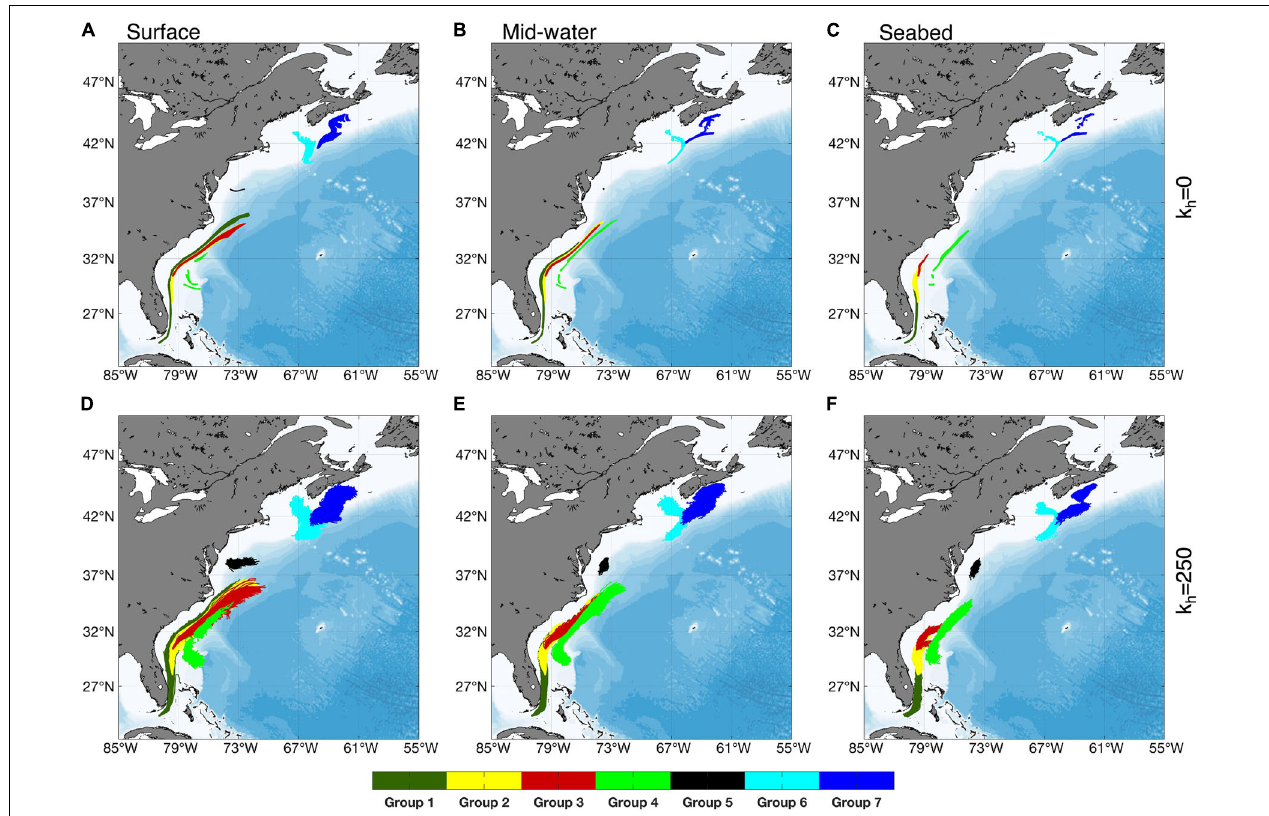
FIGURE 8 | Dispersal kernels from particle releases in July using long-term averaged currents from each of the occupied grid cells in each of the seven Groups ( Table 1 ) at three release depths (surface, (A,D) ; mid-water, (B,E) ; seabed, (C,F) when k h = 0 (A–C) , and when k h = 250 m 2 s − 1 (D–F)